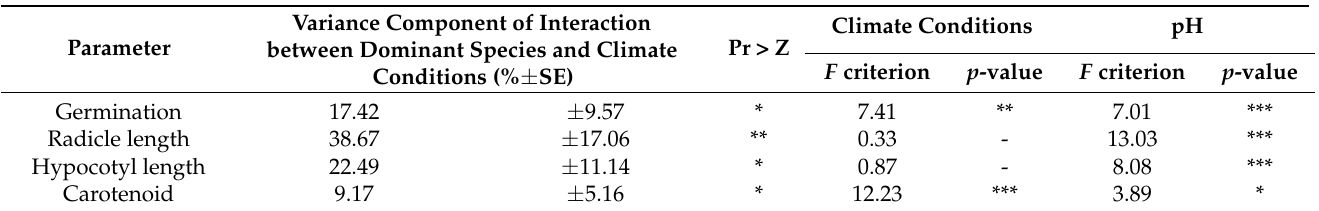
Table 4. Variance components and standard errors of random effects as well as the F criterion and significance ( p -value) of fixed effects from separate analyses for each trait (* p < 0.05, ** p < 0.01, *** p <